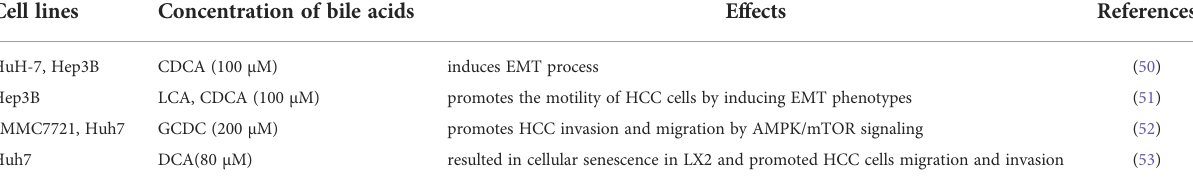
TABLE 2 Tumor metastasis promoter effects of bile acids in hepatocellular carcinoma. Cell